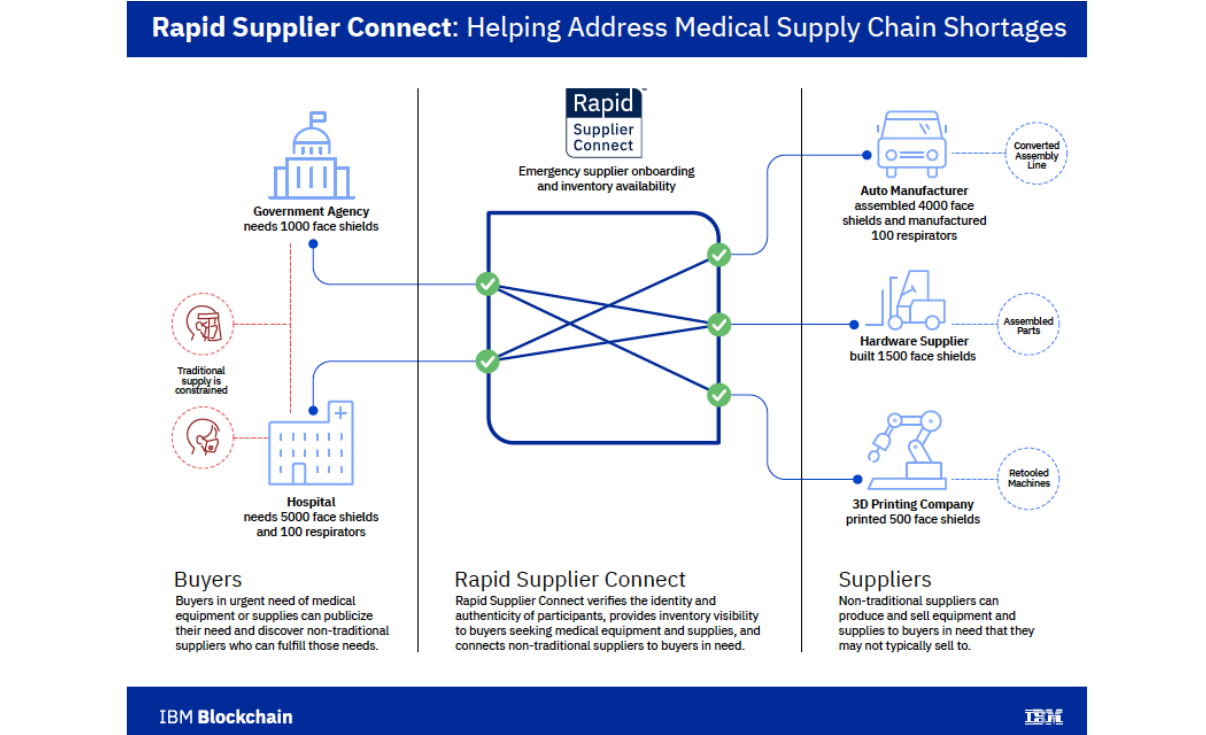
Figure 1. Schematic of IBM Rapid Supplier Connect